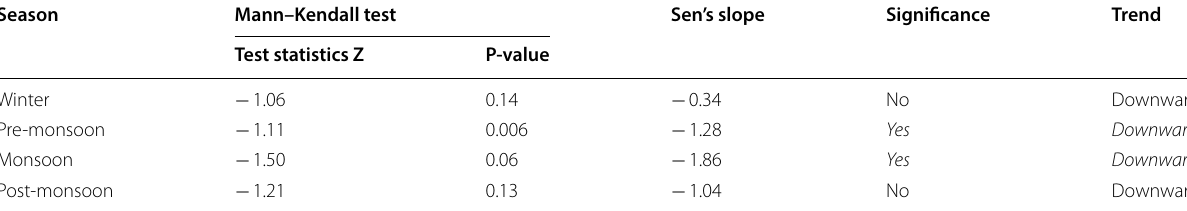
Table 3 Mann–Kendall test and Sen’s Slope Statistics of seasonal mean discharge